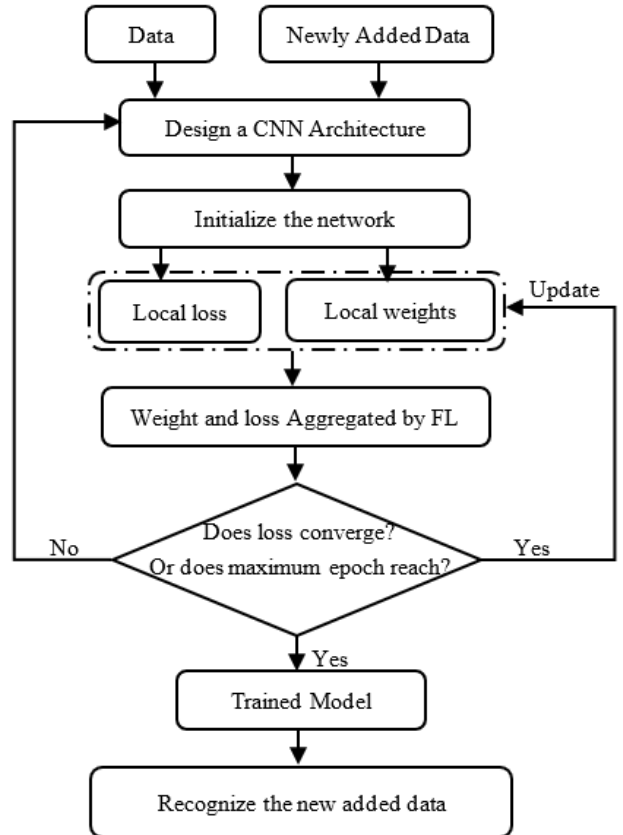
Figure 3. Flowchart of the proposed model.